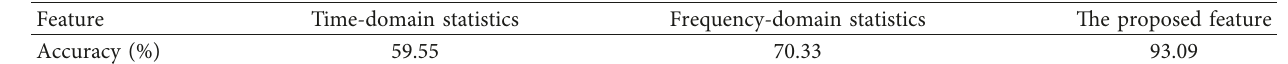
Table 5: RBF recognition results based on different